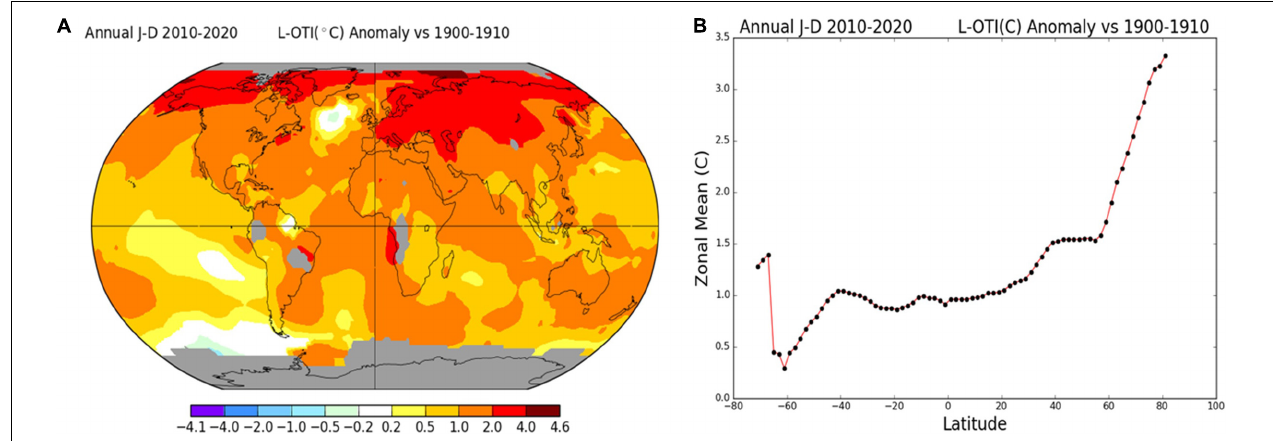
FIGURE 1 | (A) Map of annual mean temperature change ( ◦ C) during 1900–1910 and 2010–2020. (B) The zonal means plot. Air temperature data of the land surface was retrieved from GHCNv4 (GISS analysis based on global historical climatology network v4), and sea surface temperature data was retrieved from ERSST_v5 (NOAA/NCEI’s extended reconstructed sea surface temperature v5). The number at the top right-hand corner of the map plot is an estimate ( ◦ C) of the global mean of the calculated area. The maps were made using GISS Surface Temperature Analysis software